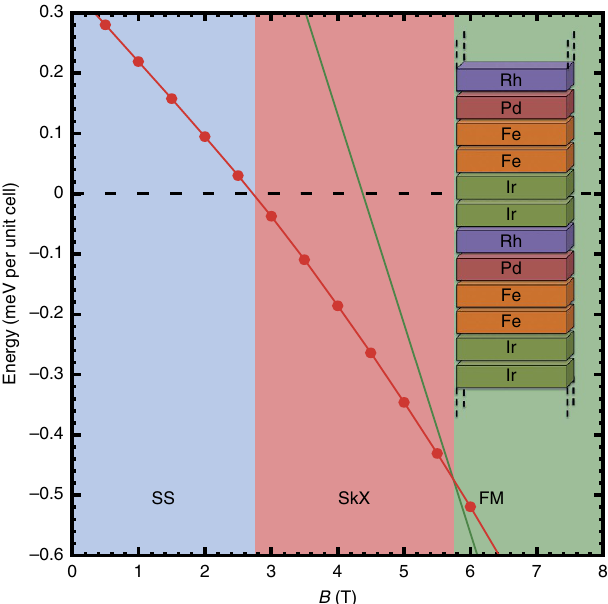
Figure 2 | Low-temperature magnetic phase diagram of the multilayer Rh/Pd/2Fe/2Ir. The total energy of the FM state (green line) and of the skyrmion lattice (SkX, red line) is shown with respect to the spin spiral (SS) state (dashed black line). The regimes of the SS, SkX and FM phase are indicated by blue, red and green colour, respectively. The multilayer structure is shown in the